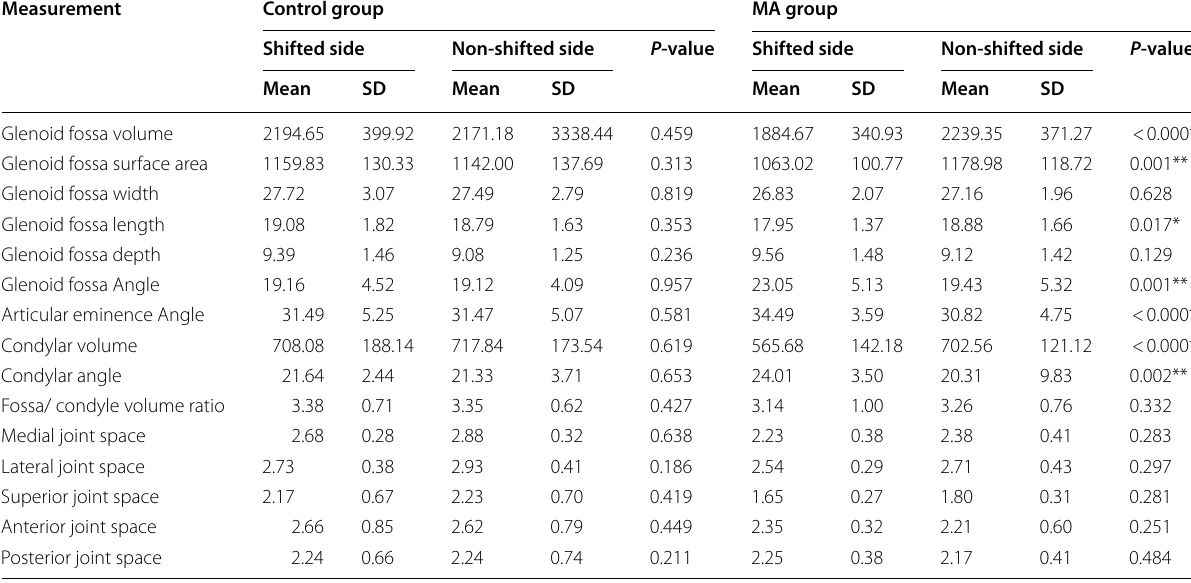
SD Standard deviation * P < 0.05, ** P <